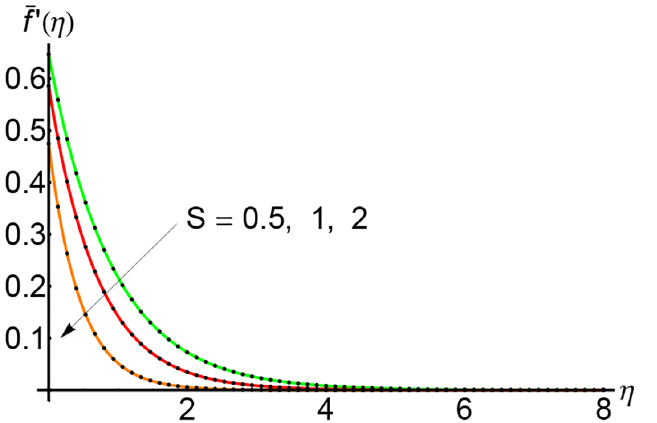
Fig 9. Variation of horizontal velocity (cid:2) f 0 ð Z Þ with η for different values of suction parameter S and for λ = 0.75: —— numerical solution ......... . OHPM solution.